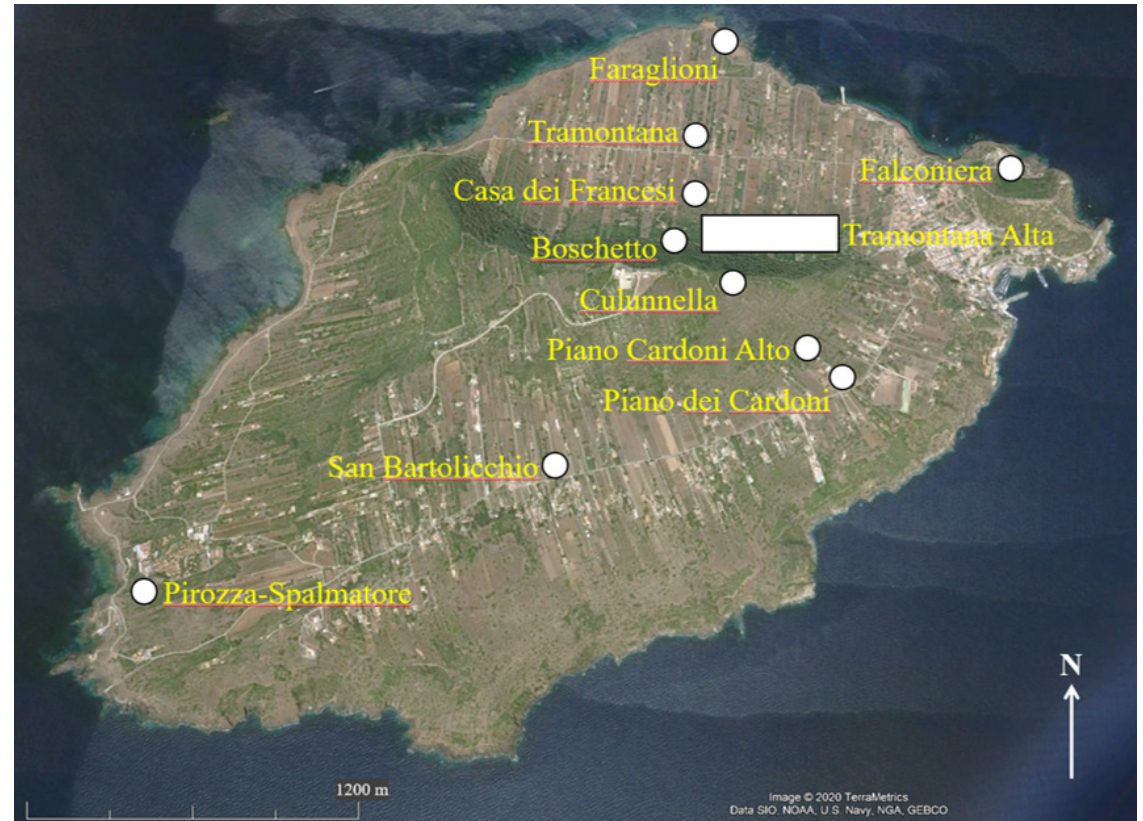
Figure 2: Map of Ustica showing prehistoric sites with obsidian. Modified from Google